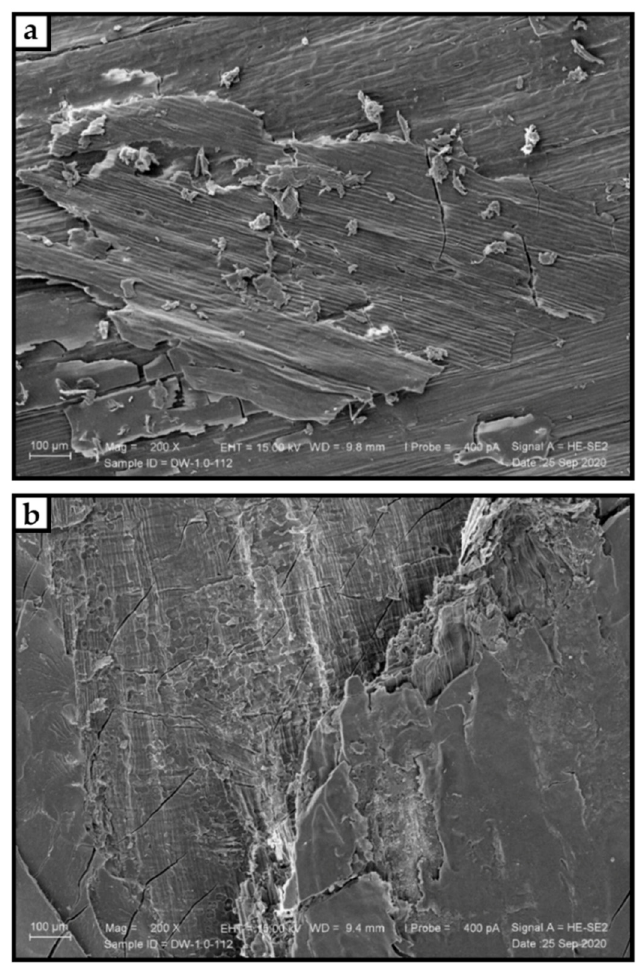
Figure 4. Increase of surface roughness of canola stalks ( a ) for particleboard panels after treatment with sodium hydroxide ( b ) [184]